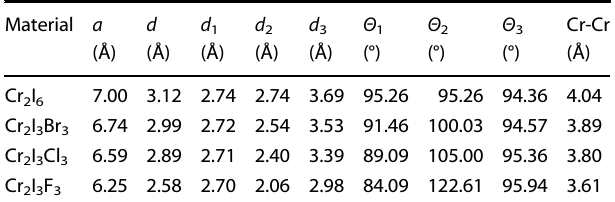
Table 1. The summarization of structure parameters of 2D Cr 2 I 6 and Janus